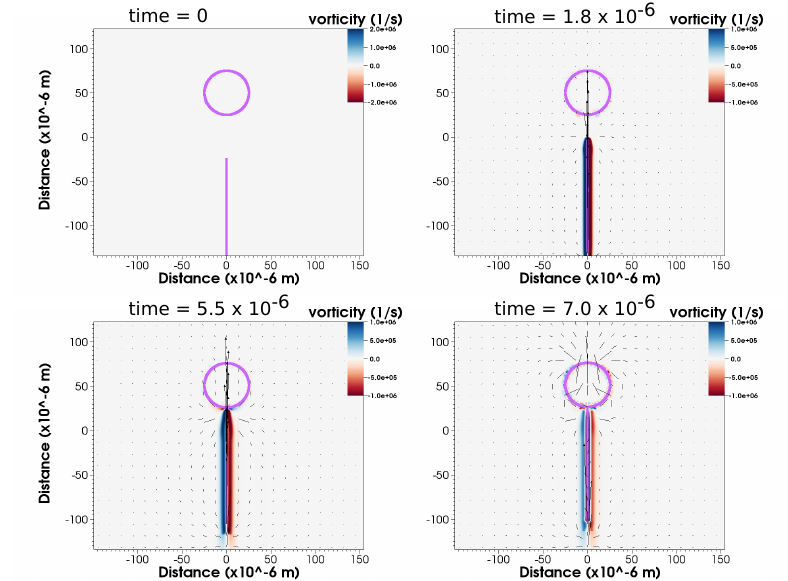
Figure 9. Temporal snapshots showing the vorticity and fluid velocity for Re = 900 with a barb whose length is 2.5 times the base length. The position of the barb and prey are denoted by magenta, the color map represents the vorticity, and the arrows indicate the fluid